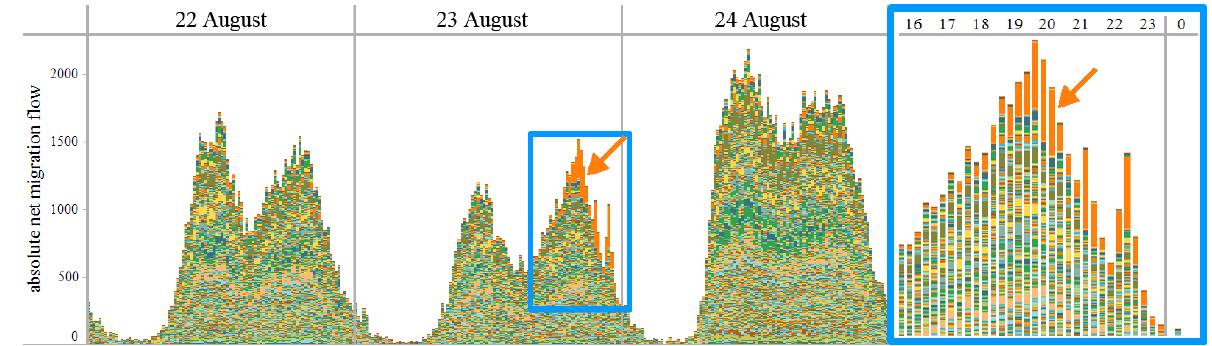
Figure 9. Soccer game Udinese versus AC Milan (Stadio Friuli, Udine) on Sunday, 23 August 2009.